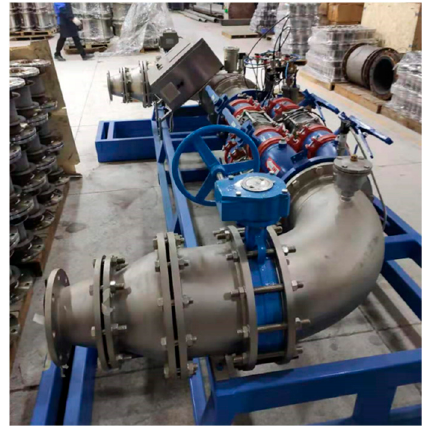
Figure 4. The pressure-regulating device.